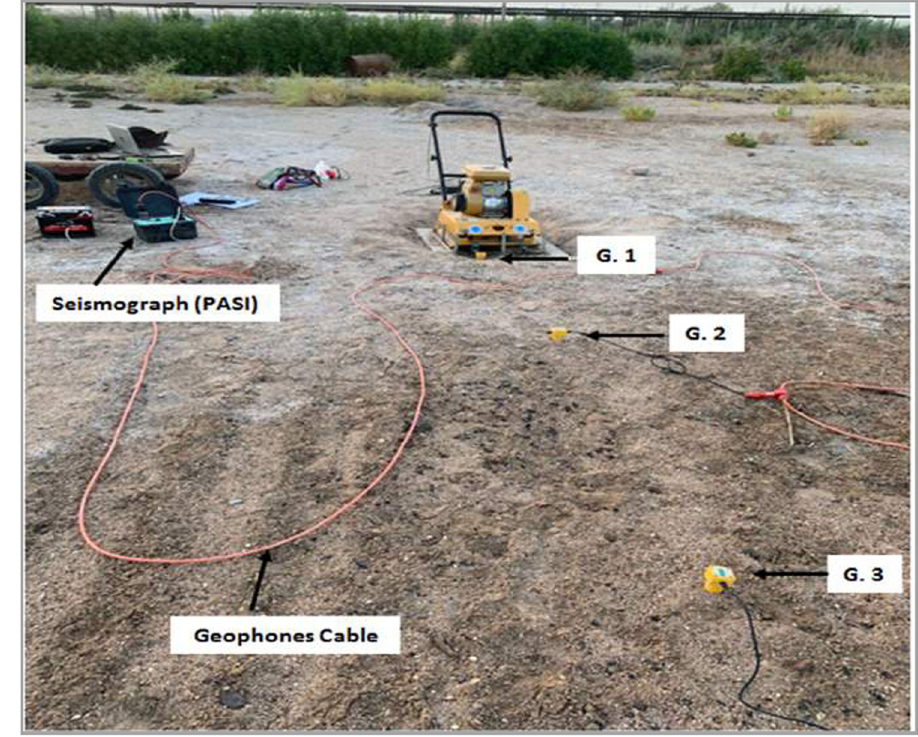
Figure 5: Arrangement of fi eld test devices.